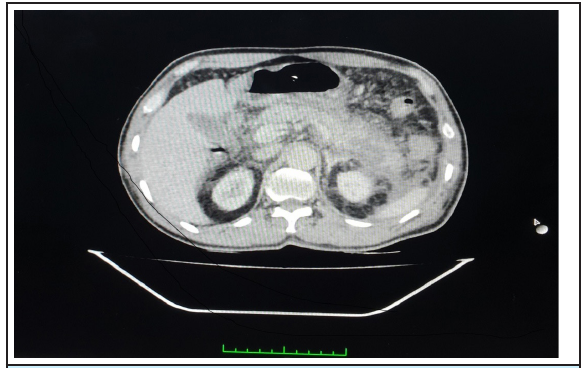
Figure 3. Contrast-enhanced computed tomography of abdomen shows pancreatic necrosis in 30% with swollen neck and tail, peripancreatic inflammation and fluid